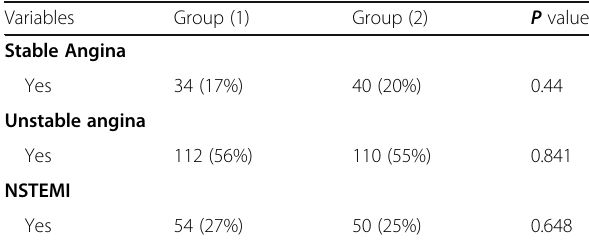
Table 2 Baseline clinical presentations